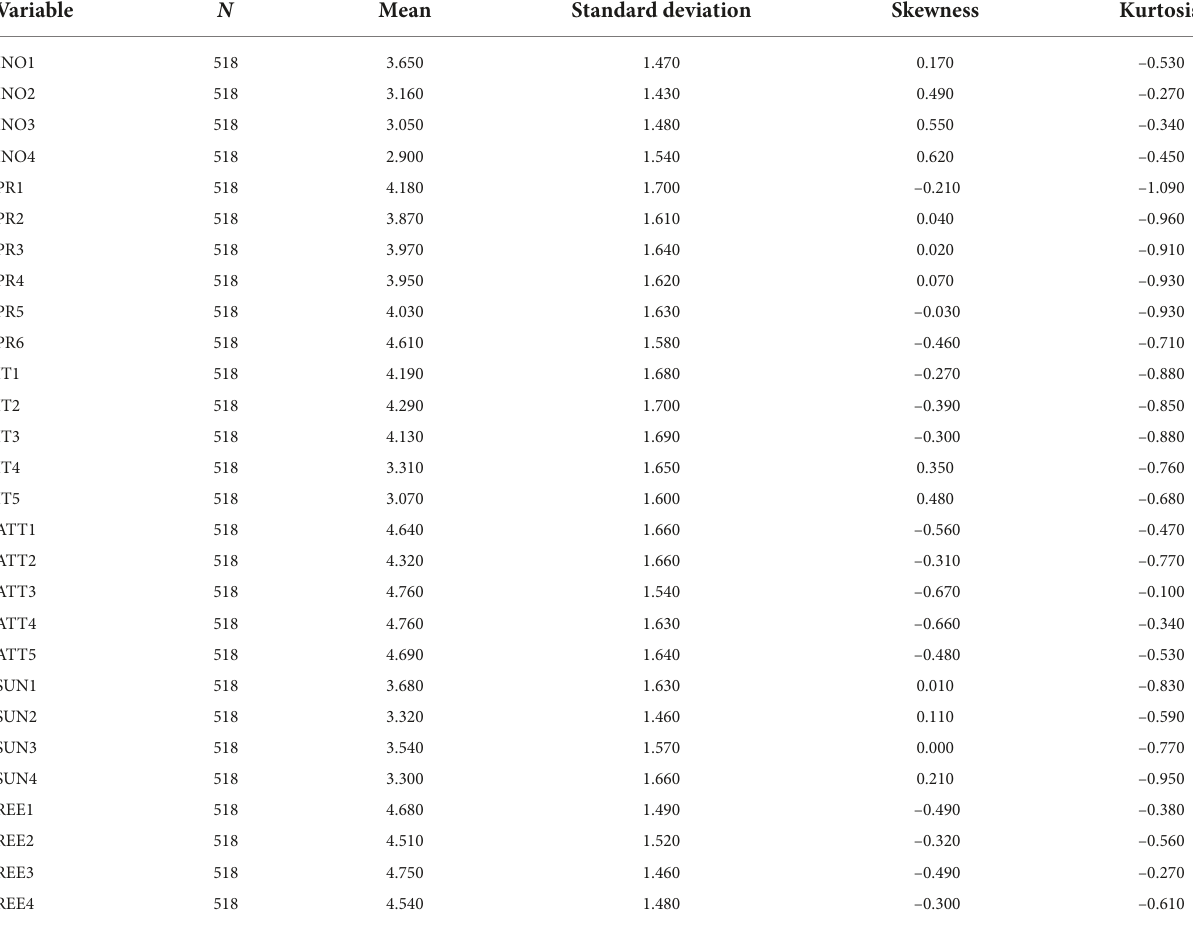
TABLE 3 Mean and standard deviation for